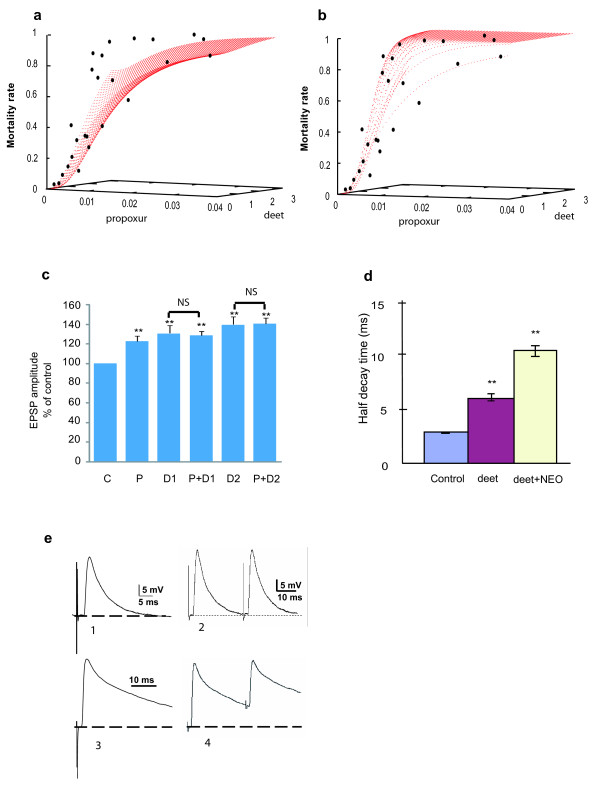
Interactions between deet and anti-cholinesterasic compounds. a) and b) Toxic interactions between deet (μg/mg mosquito) and propoxur (μg/mg mosquito) for C. quinquefasciatus by topical application. The model including a synergistic interaction (b) between the two molecules provided a better description of the data than a model based on simply additive effects (a); see equations  where ED is the effective dose, D the dose and ic the interaction coefficient. The interaction coefficient (ic = 3.07 ± 0.98) was significantly greater than 0, indicating that deet synergised propoxur toxicity in insects. c) Effects of propoxur (P) and deet (D), alone and in combination (P+D), on cockroach synaptic activity. All synaptic preparations were pretreated (10 min) with atropine (1 μM). NS not significant (P > 0.05). d) Effect of deet and neostigmine on the time course of full size EPPS recorded in mouse hemidiaphragm preparations. Mean values (± s.e.m, n = 6) of the half-decay time of EPPs (ms) under control conditions (2.8 ± 0.05 ms, blue column), 500 μM deet (6.1 ± 0.36 ms, red column) and in the continuous presence of deet and 3 μM neostigmine (10.5 ± 0.55 ms, yellow column). * denotes a significant difference from controls (P < 0.001). e) Examples of full size endplate potentials (EPPs) in response to a single or paired stimulus in the presence of 500 μM deet and in the presence of deet (upper part) and 3 μM neostigmine (lower part). * denote significant difference from control P < 0.001.